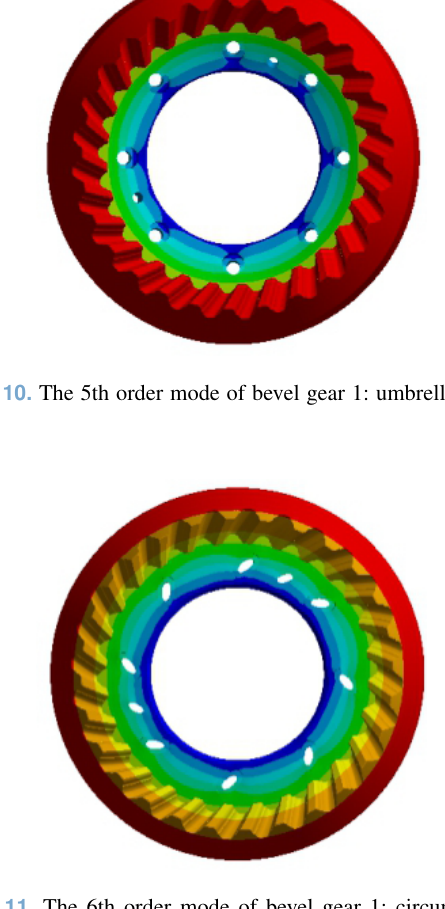
Figure 11. The 6th order mode of bevel gear 1: circumferential